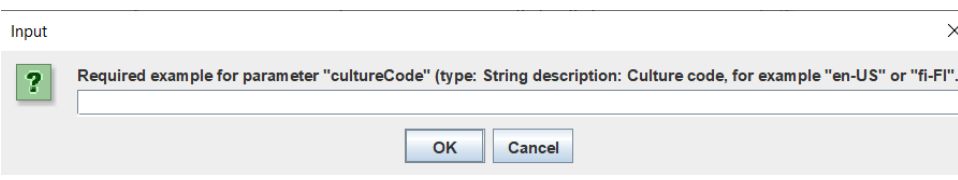
Figure 5. User input dialog example.